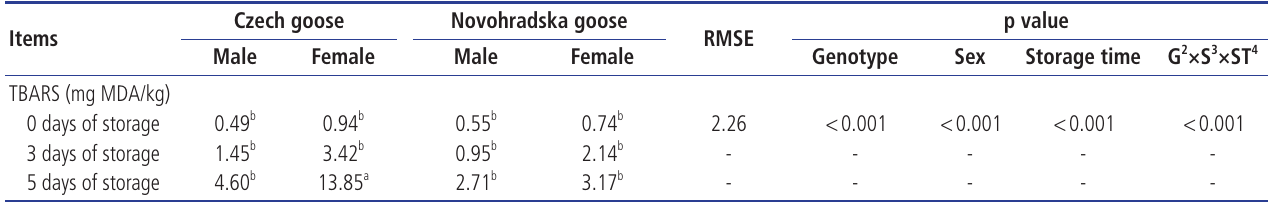
Table 4. Oxidative stability of goose meat as affected by genotype, sex, and storage time Czech Items